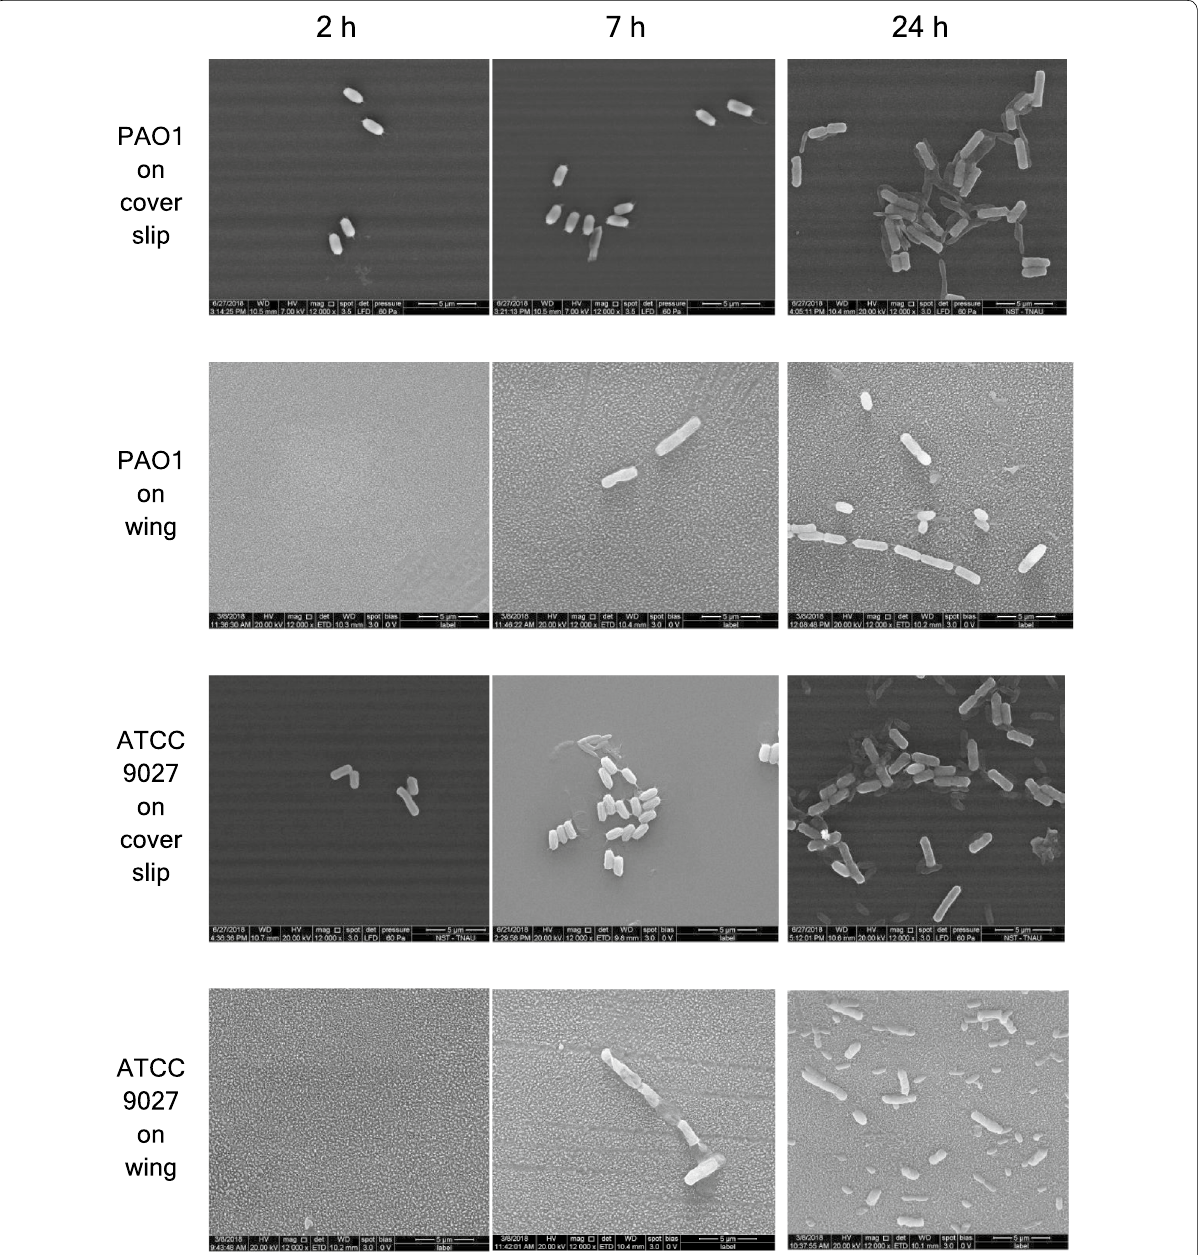
Fig. 3 FESEM images of P. aeruginosa ATCC 9027 and PAO1 on glass cover slip and on the wing of Pantala flavescens . Magnification— bars represent 5